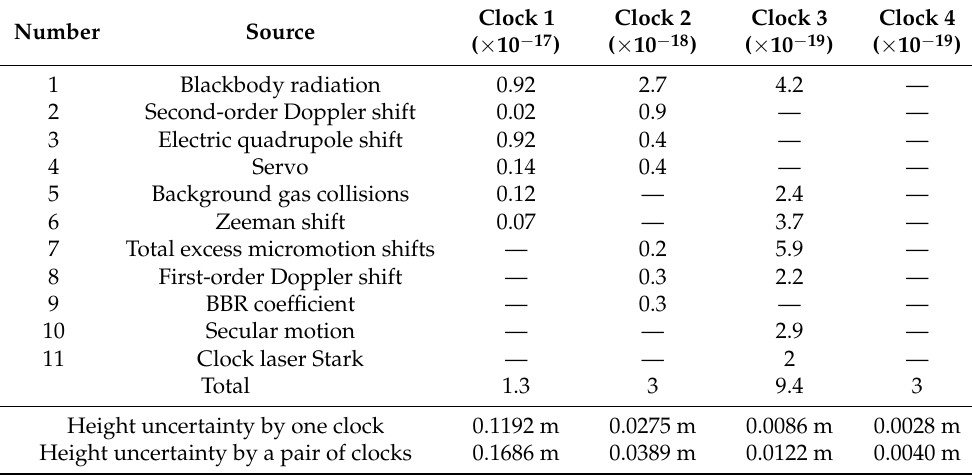
Table 1. Measurement systematic error items of existing and potential optical